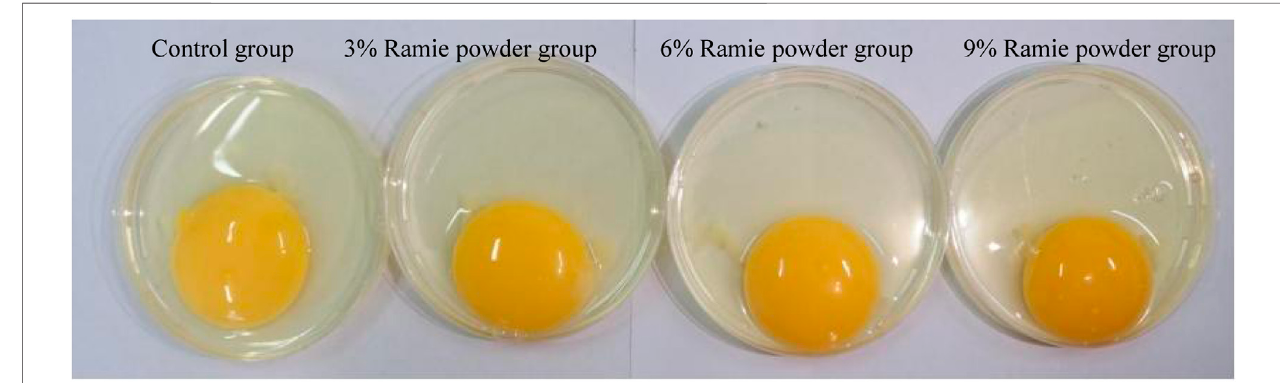
FIGURE 1 | Effect of diet on egg yolk color of laying hens (40 weeks of age). From left to right: control, 3, 6, 9% ramie supplementation diets in turn.